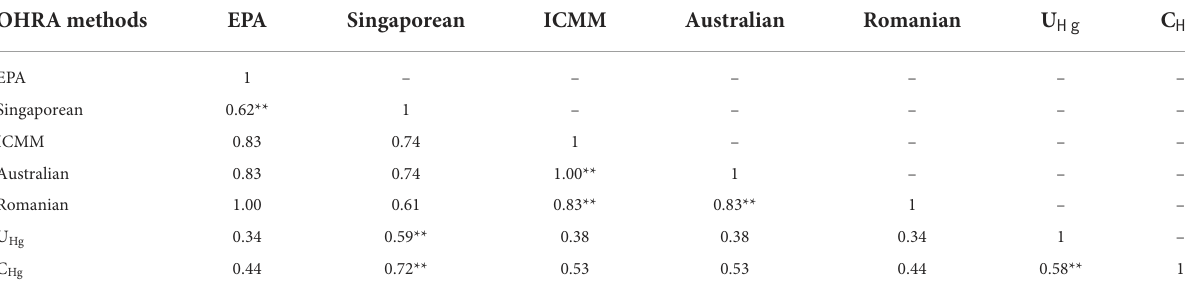
TABLE 4 Correlation analyses between risk ratios and Hg concentrations in air and urine samples. OHRA methods